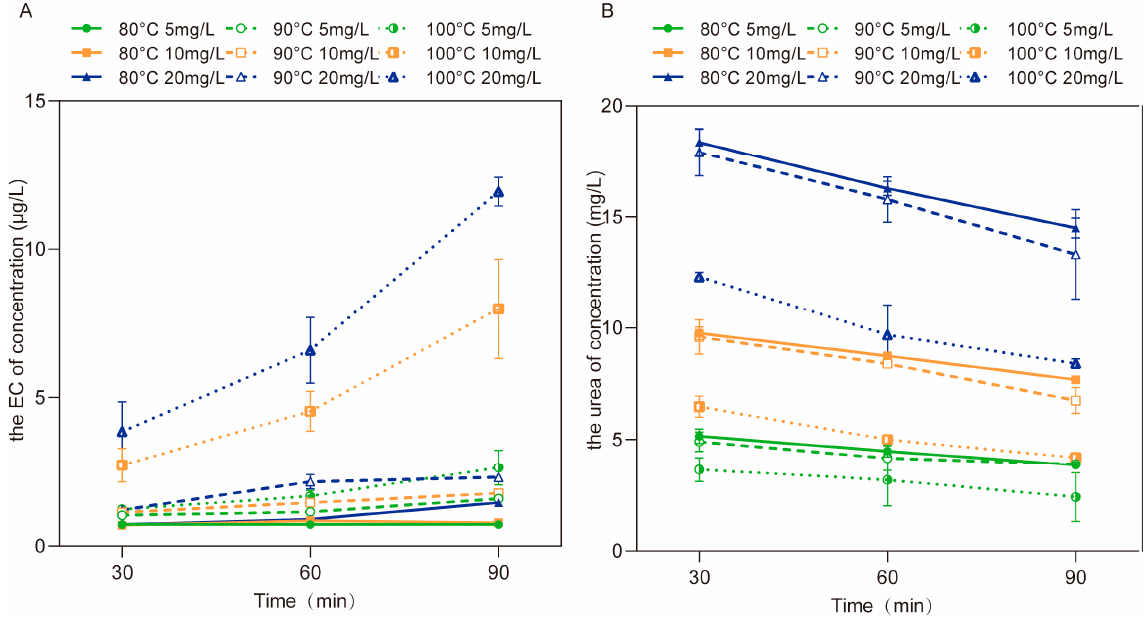
Figure 3. The concentrations of EC ( A ) and urea ( B ) during the aqueous reactions between urea (5.0, 10.0 and 20.0 mg/L) and ethanol (2%) at 80 °C, 90 °C and 100 °C, respectively. 10.0 and 20.0 mg/L) and ethanol (2%) at 80 ◦ C, 90 ◦ C and 100 ◦ C,